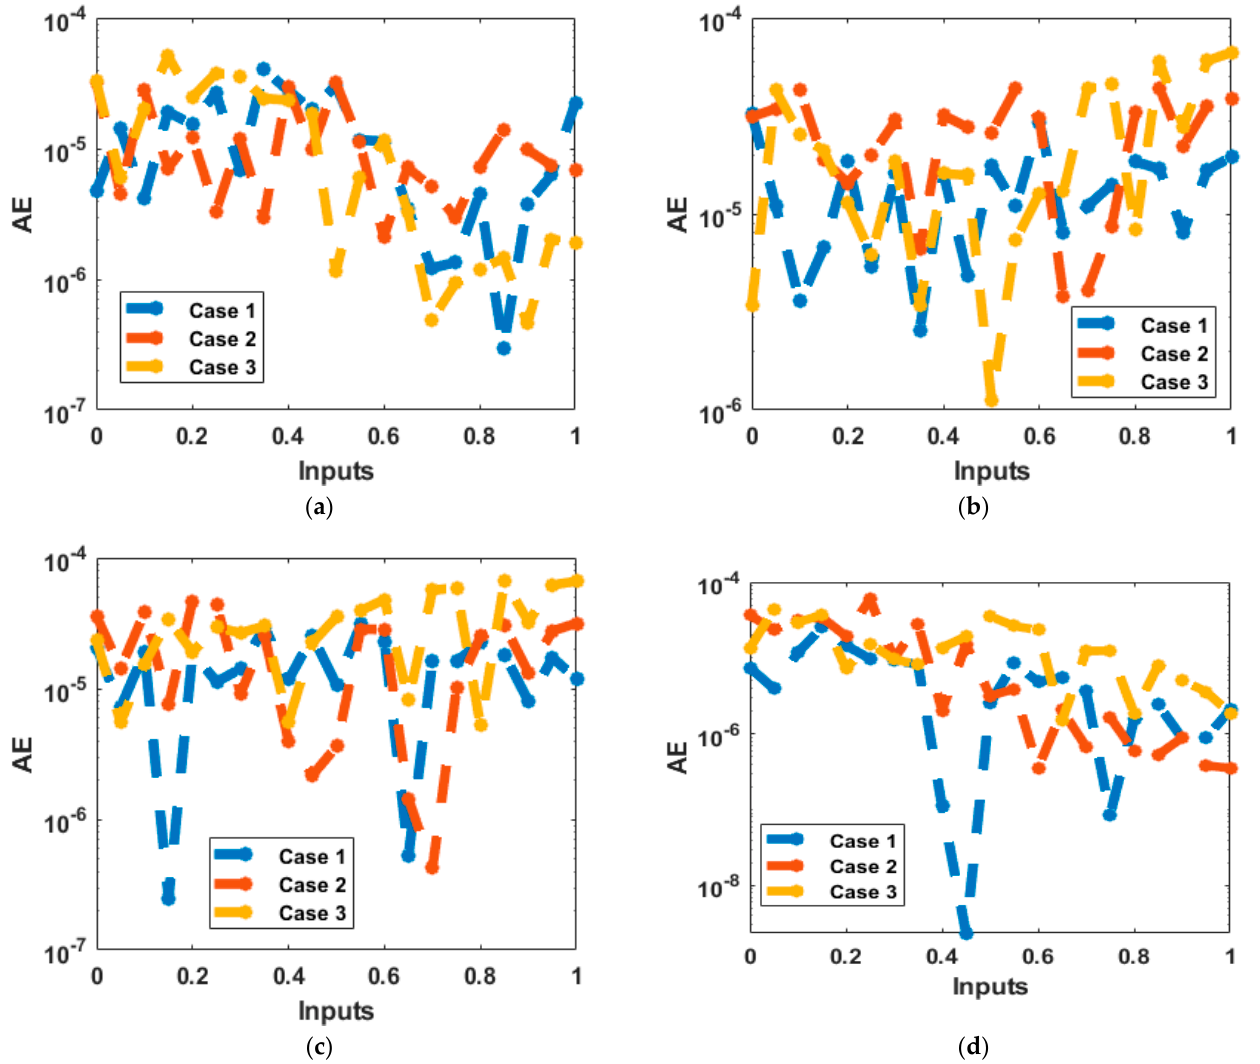
Figure 8. ( a – d ) AE outcomes of ANNLMB for solving heat transfer in spinning nanofluid. ( a ) AE: Scenario 1; ( b ) AE: Scenario 2; ( c ) AE: Scenario 3; ( d ) AE: Scenario 4. Table 5. ANNLMB outcomes of Scenario 3 for heat transfer in spinning Table 3. ANNLMB outcomes of Scenario 1 for heat transfer in spinning nanofluid.